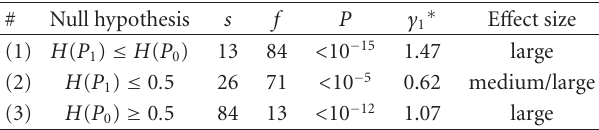
Table 5: Hypothesis tests where s and f are the number of success and failures for trials 1–100 without nonstationary trials 63, 68, and